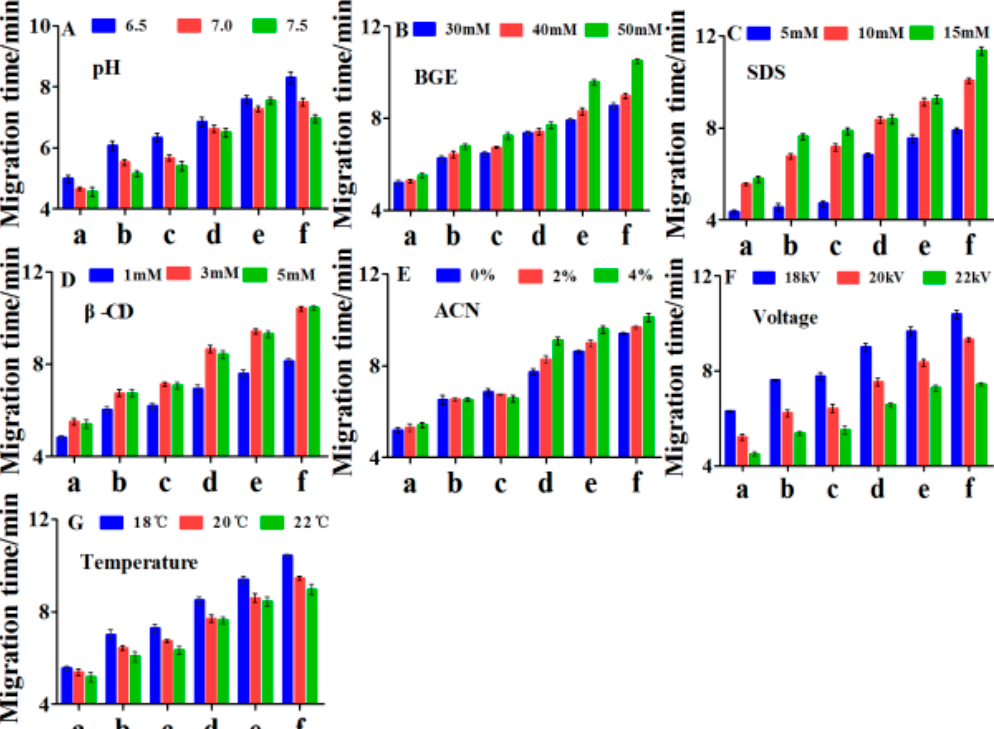
Figure 1. The effects of parameters on migration time of six peaks. ( A ) The effect of buffer pH on migration time, ( B ) the effect of buffer concentration on migration time, ( C ) the effect of SDS concentration on migration time, ( D ) the effect of β -CD concentration on migration time, ( E ) the effect of acetonitrile concentration on migration time, ( F ) the effect of voltage on migration time, ( G ) the effect of temperature on migration time.(a: Rutin, b: Kaempferol-3-rutinoside, c: Narcissoside, d: Ferrozine, e: [Fe(ferrozine)3] 2+, f: Quercetin). BGE: background electrolyte; SDS: sodium dodecyl sulfate; β -CD: β -cyclodextrin; ACN: acetonitrile